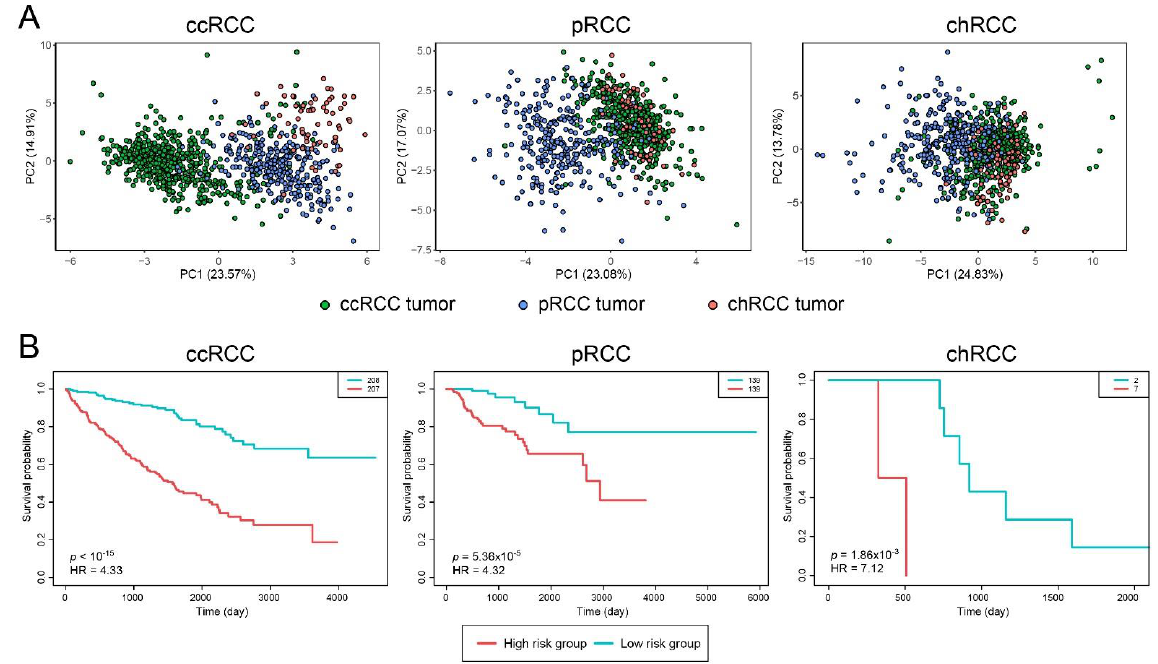
Figure 3. Diagnostic and prognostic performance analysis results for Renal Cell Carcinoma (RCC) subtypes. ( A ) Principal component analyses (PCA) plots, visualized by considering s-DIPs, indicating the individual differences in the gene expression profiles in tumor samples among the subtypes. ( B ) Kaplan–Meier curves estimating patients’ survival for three subtypes based on categorization of patients into high- and low-risk groups via prognostic index. ccRCC: Clear Cell Renal Carcinoma; pRCC: Papillary Renal Cell Carcinoma; chRCC: Chromophobe Renal Cell Carcinoma; HR: Hazard Ratio; PC: Principal component.